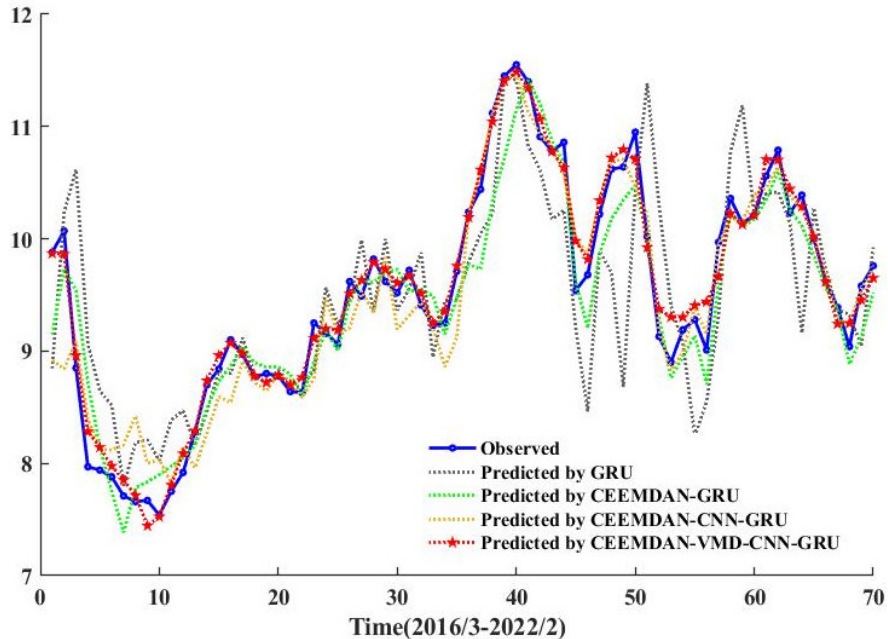
Figure 10. Comparison of prediction results from different models.